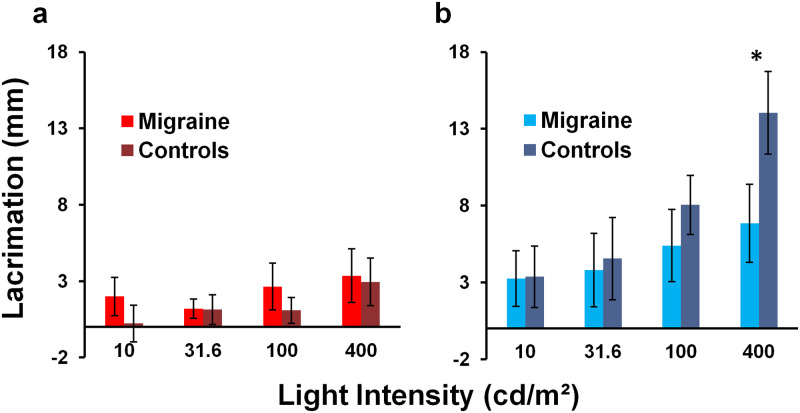
Mean light-induced lacrimation of the right eye.Lacrimation was measured using a 1-min anesthetized Schirmer’s test (mm) in response to four light intensity steps, each of 400 ms duration, using (a) red and (b) blue light stimulation. Error bars represent 95% confidence intervals. The asterisk indicates significantly lower tear production in participants with migraine compared to controls at the highest blue light intensity (p = 0.001).